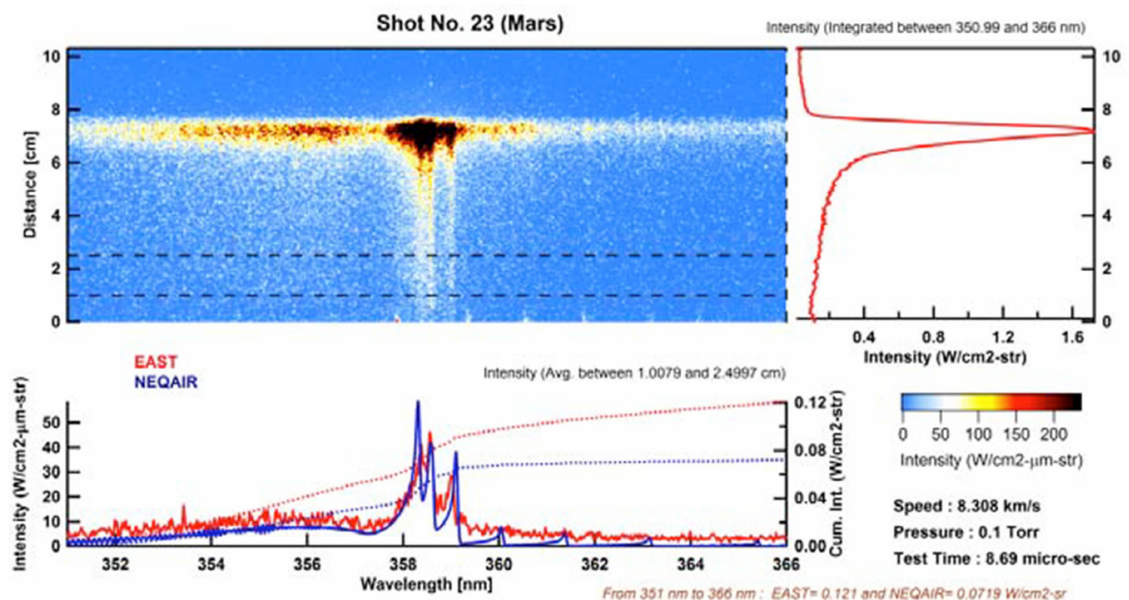
Figure 20. Comparison between NEQAIR calculations and EAST data in the UV range, at shock velocity of 8.55 km/s and a pressure of 0.1 Torr. The dotted curves are the cumulated intensity: measured in red and computed in blue (from